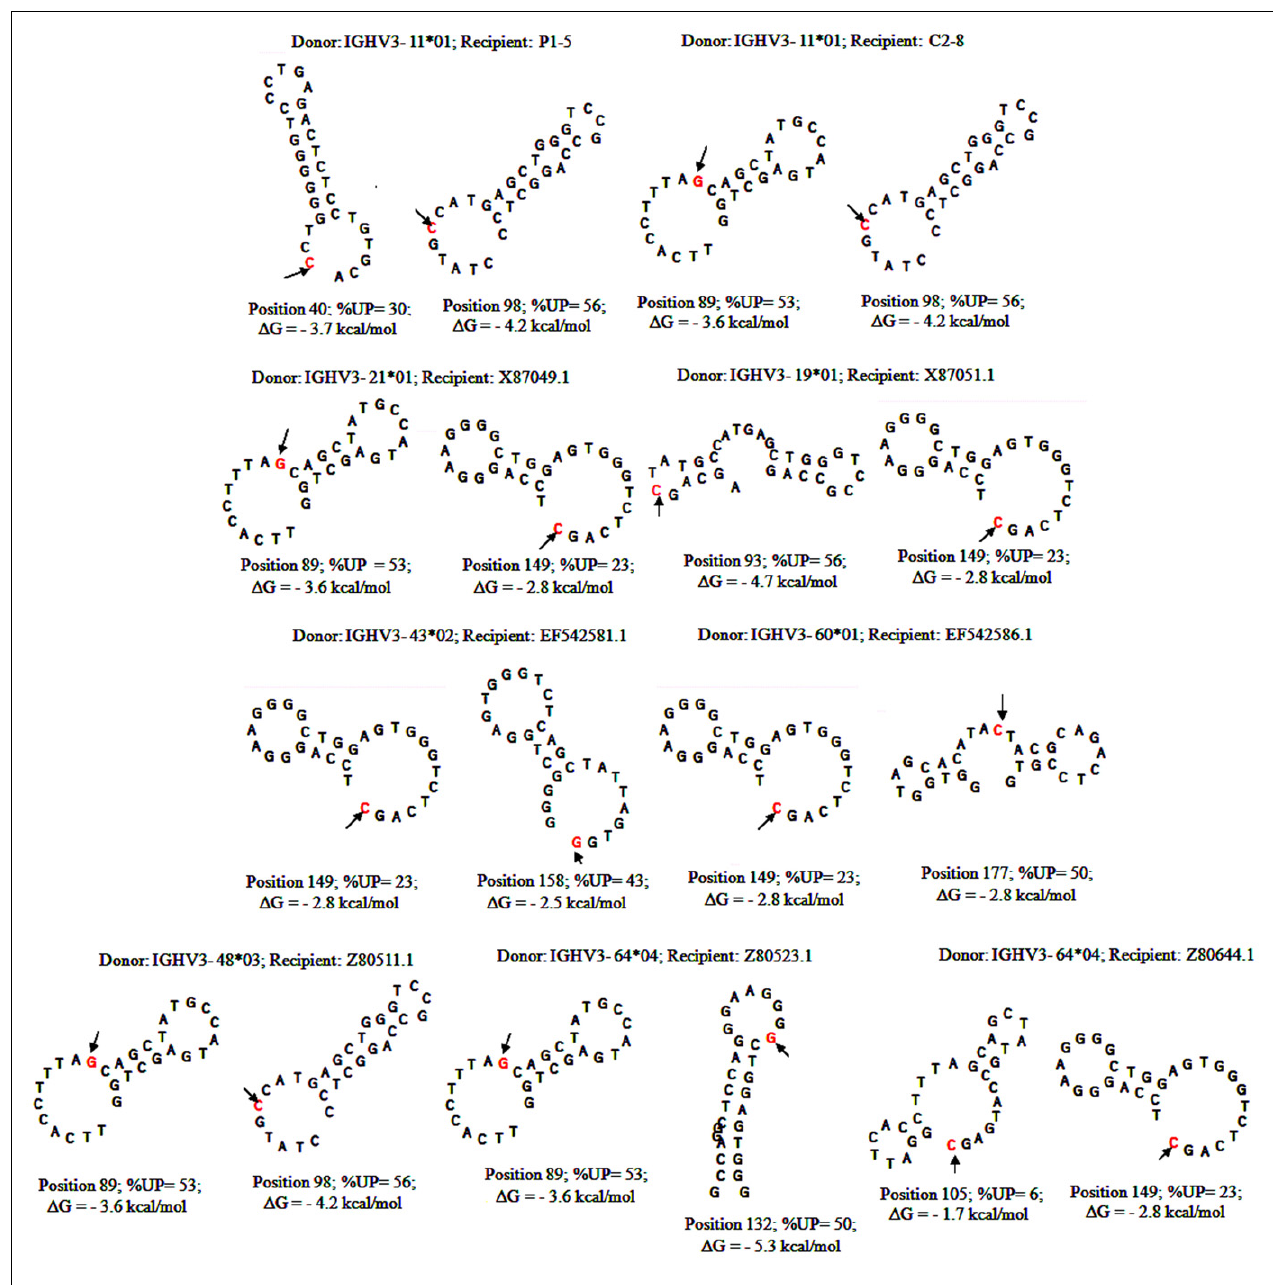
structure flanking GCV-like tracts are named as the rearranged IGHV3-23*01 sequences shown in Figures 1 – 4 .The hypermutable bases are shown with arrows. DNA secondary structural parameters, − Δ G , % Unpaired (%UP) correspond to hypermutable base (shown with arrows).